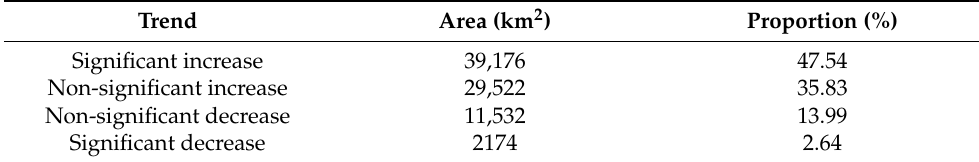
Table 4. Area and proportion of vegetation cover affected by human activities.